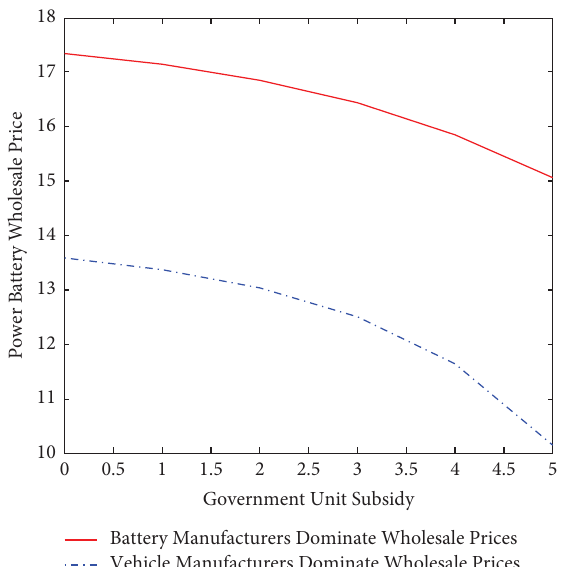
Figure 1: Te infuence of government subsidies on wholesale prices under diferent power structures.